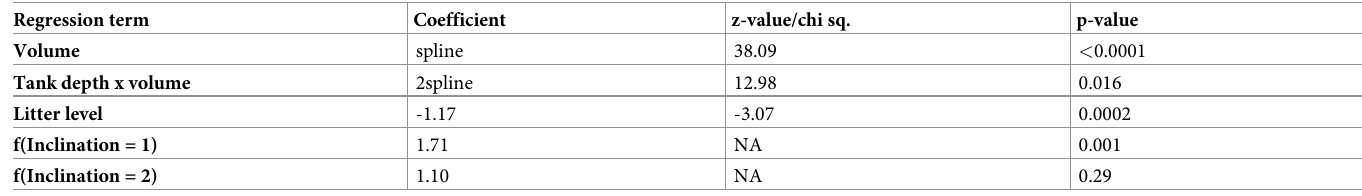
Table 3. The best-fitting model (lowest AICc) explaining reproductive site selection. Adjusted R 2 = 0.66. Spline = cubic spline fitted, 2spline = cubic spline fitted to both terms simultaneously (i.e. a non-linear interaction). Z-values are shown for parametric terms and Chi-squared values for fitted splines. All variables are z-standard- ized. x = interaction. NA = not transformed in the